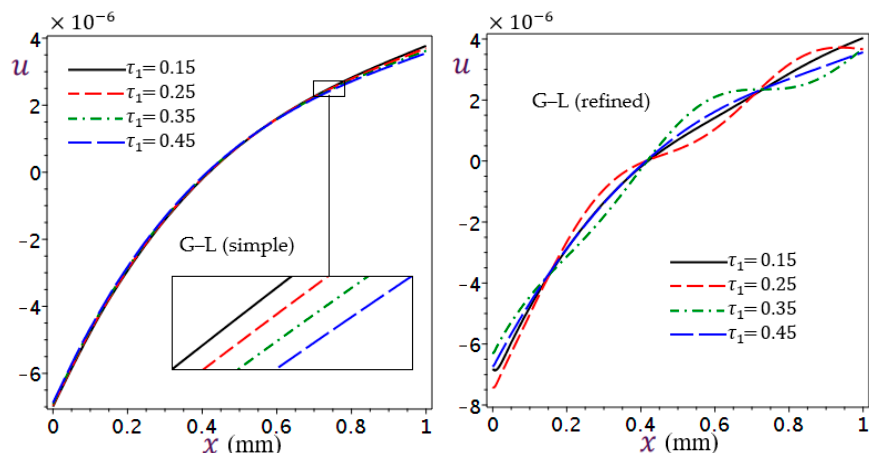
Figure 10. Effect of first relaxation time τ 1 of G–L theory on temperature θ .